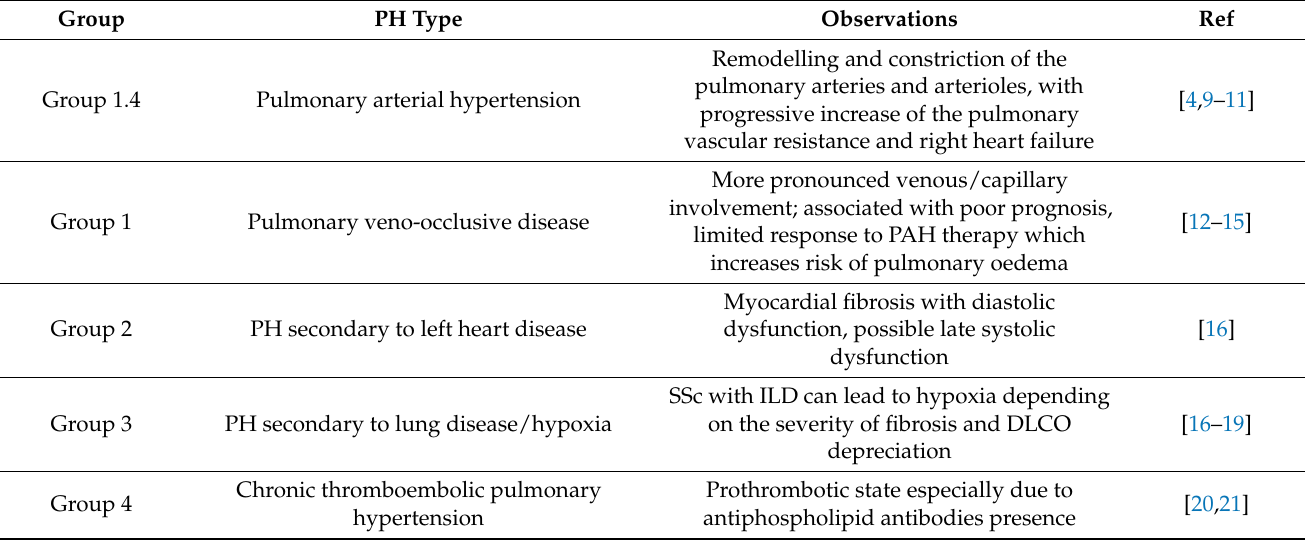
Table 1. Possible causes of PH in SSc. Legend: PAH–pulmonary arterial hypertension, PVOD–pulmonary veno-occlusive disease, ILD–interstitial lung disease, DLCO–diffusing capacity for carbon monoxide, CTEPH–chronic thromboembolic pulmonary